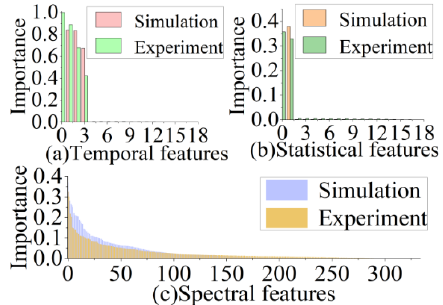
Figure 8. Temporal, statistical, and spectral feature importance analysis on simulated and experimen- tal